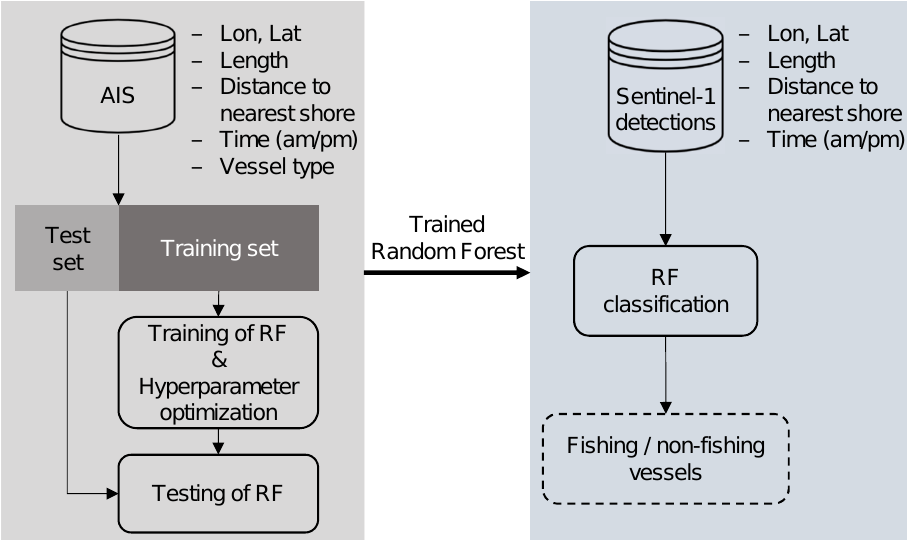
Figure 5. The Random Forest classifier is trained and tested on the AIS dataset to classify fishing and non-fishing vessels based on their geographical position (longitude, latitude), their length, their distance to the nearest shore, and whether it is a morning or afternoon measurement. After training and testing, the classifier is applied to the Sentinel-1 detections to isolate the fishing